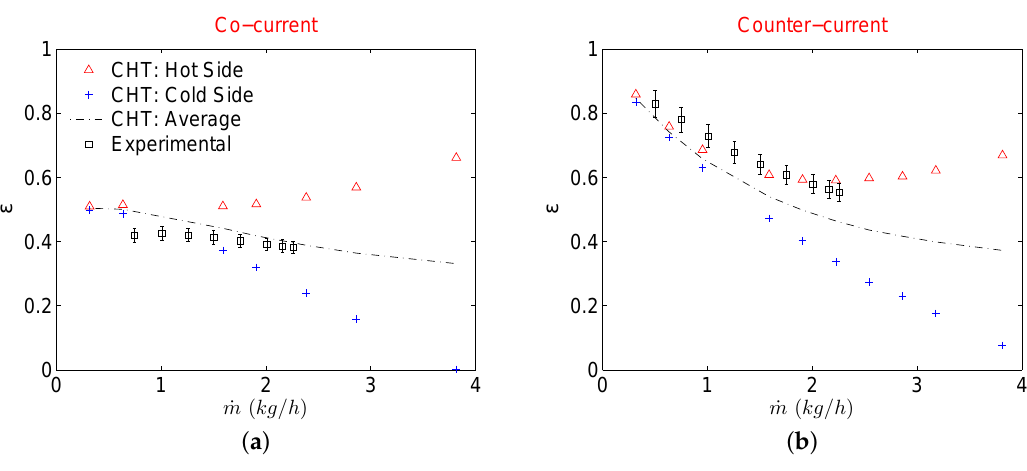
Figure 5. Heat exchanger effectiveness for CHT analysis when flow configuration is cocurrent ( a ), and counterflow ( b